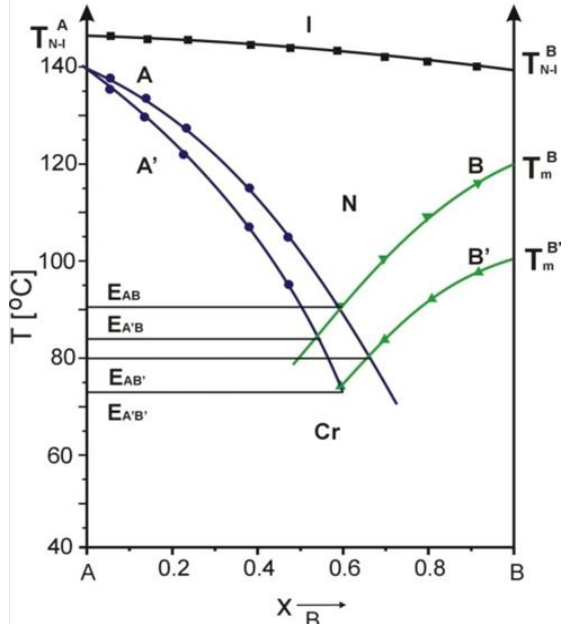
Figure 2. Phase diagram—theoretical miscibility curves of compound A and compound B (or Aʹ and Bʹ) in their nematic phase for the case of total immiscibility of these compounds in the solid phase and ideal miscibility in the nematic phase. For binary system A and B at eutectic point, components A and B melt together. Distinct from the eutectic composition by heating, only at first, one component is melting, hereafter reaching the eutectic composition, both A and B are melting at eutectic ratio. The compounds have the following parameters: T (A) = 140 °C and  H (A) = 24 kJ/mol or  H (Aʹ) = 16 kJ/mol; m m m T (B) = 120 °C and  H (B) = 20 kJ/mol or T (Bʹ) = 100 °C and  H (Bʹ) = 20 m m m m